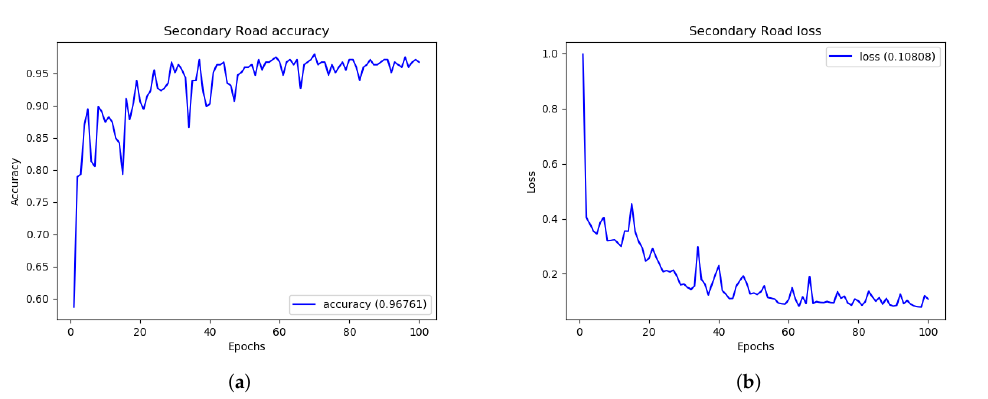
Figure 11. Road detection performances: secondary road accuracy and secondary road loss. In the plot ( a ) the accuracy, in the plot ( b ) the